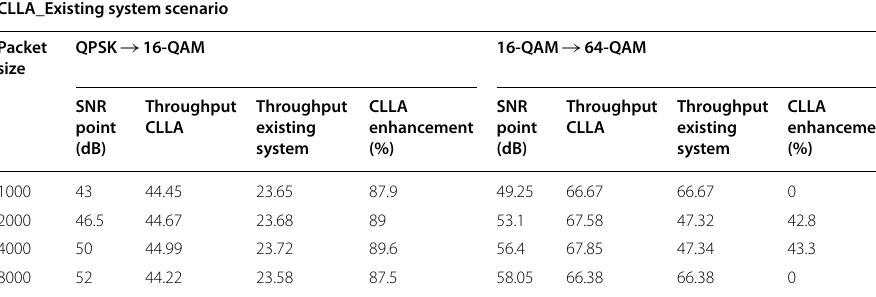
Table 7 Experimental results of CLLA _ Existing system CLLA_Existing system